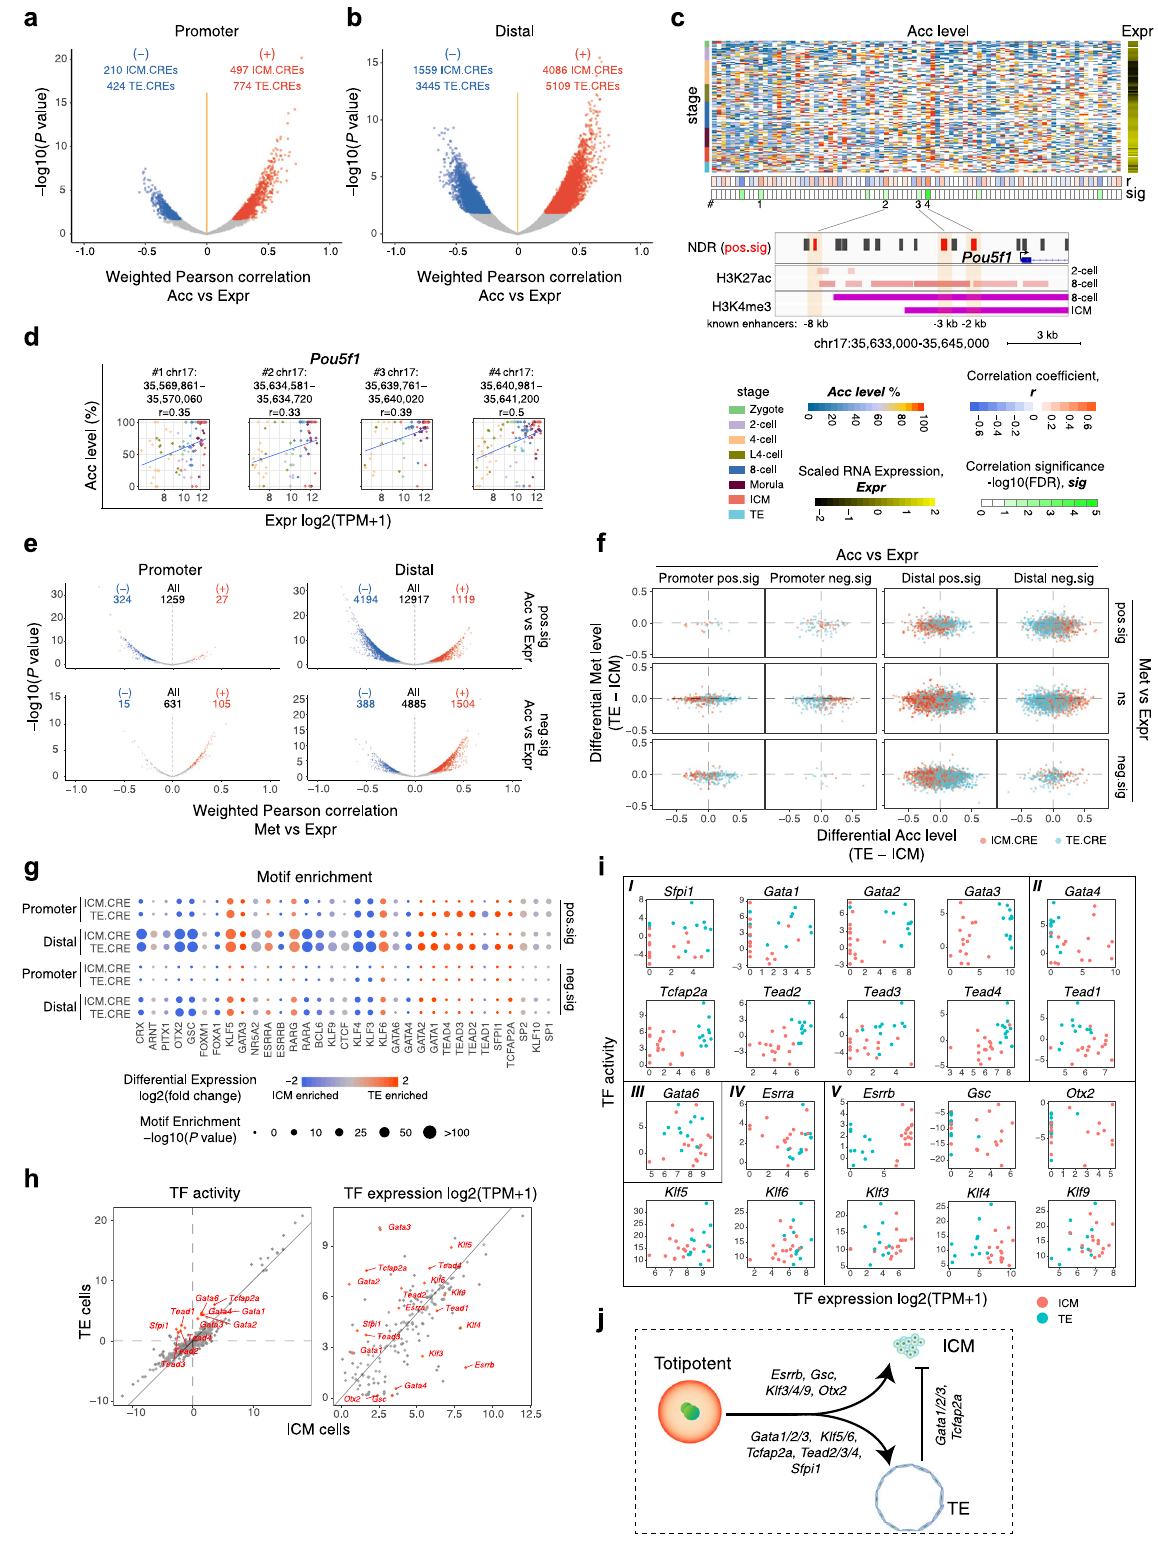
Copy number variation detection using scBS-seq data . To detect the CNV in each cell based on the scBS-seq data, we inferred the CNVs using the HMMcopy 46 R package. First, the sequenced reads were counted with readCounter in 1Mb bins across the mouse genome, and the read count of each bin was adjusted by correcting for the GC content and genomic mappability. Then, the median adjusted read counts of the consecutive bins were used to infer the CNVs of the genomic regions.